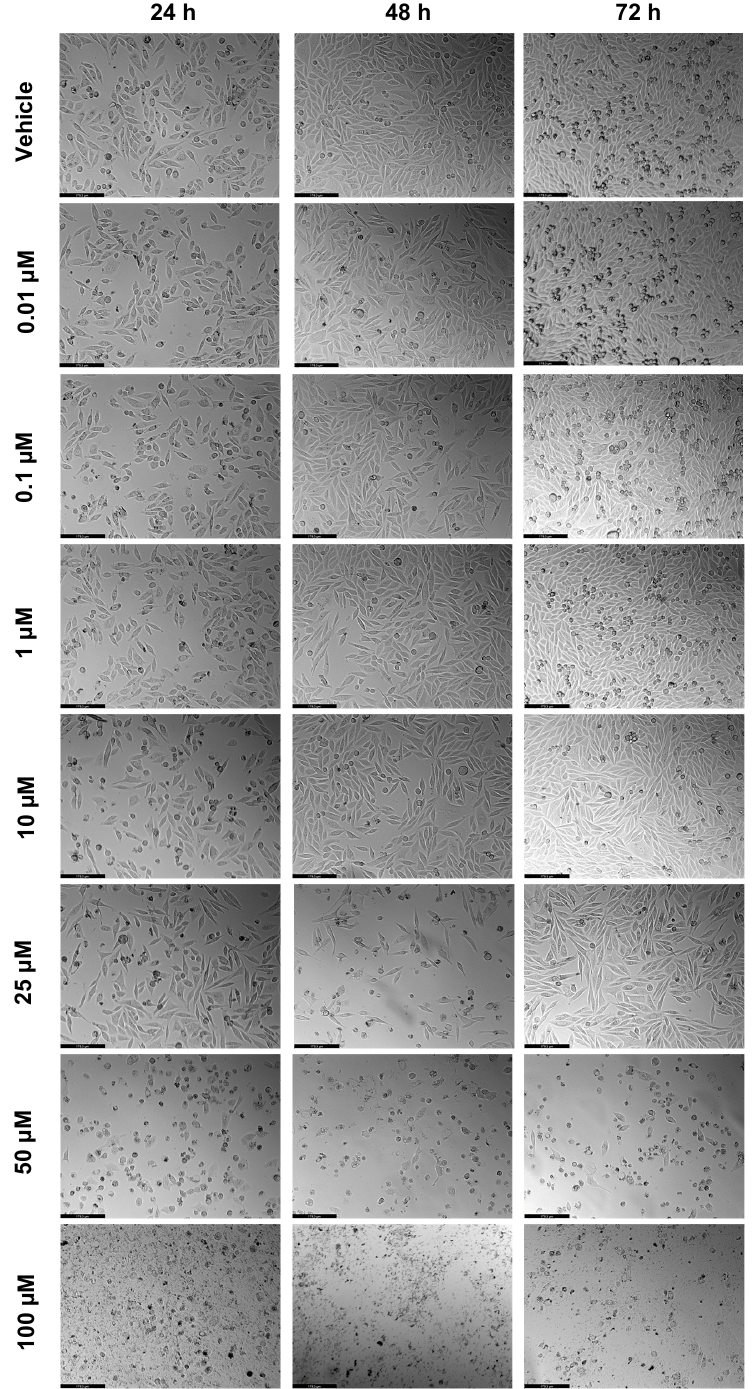
Figure 5. Morphological evaluation of PC-3 after exposure to increasing concentrations of SAQ (0.01–100 μ M) for 24, 48, and 72 h. Control cells were treated with the vehicle (0.01% DMSO). These images are representative of three independent experiments for 24 h, and six independent experiments for 48 h and 72 h. The scale bar is 200 μ M.